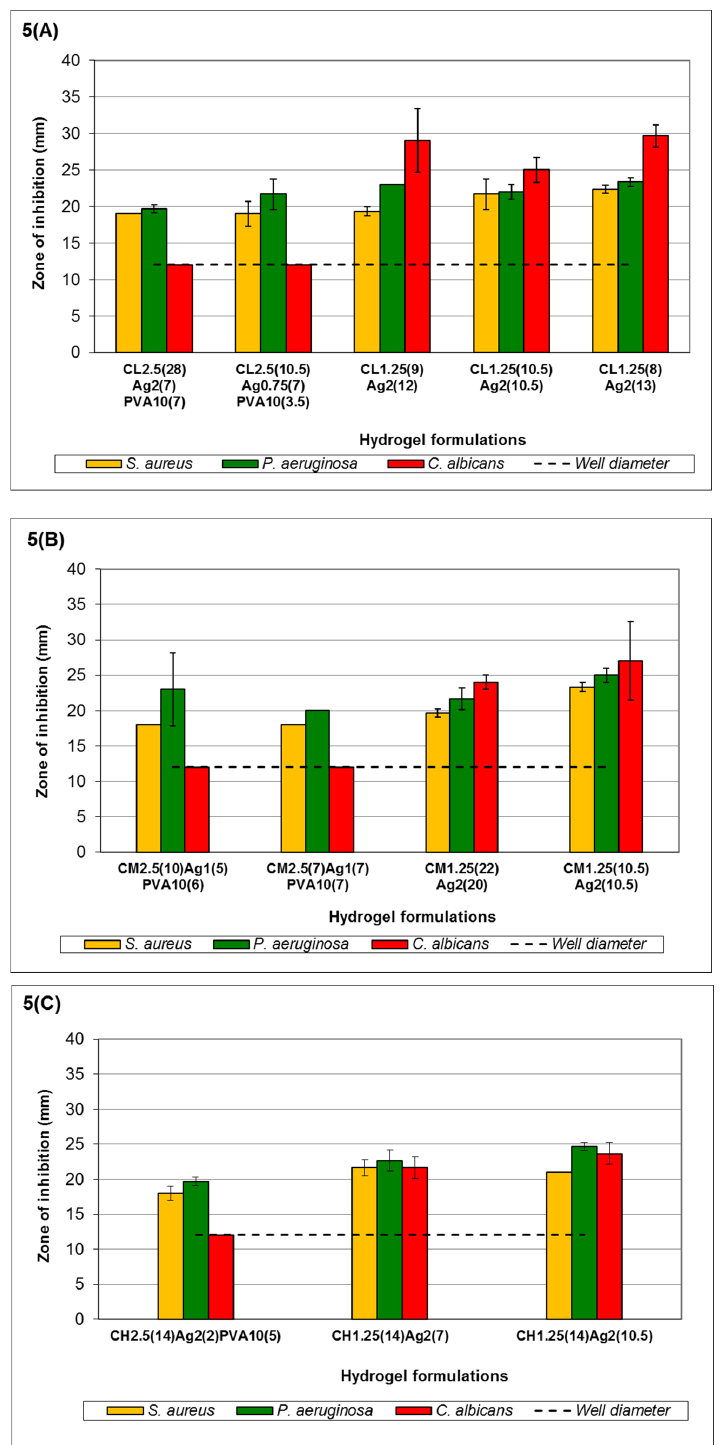
Figure 5. Antimicrobial activity of Ag + hydrogels formulated with ( A ) low ‐ viscosity chitosan; ( B ) medium ‐ viscosity chitosan; and ( C ) high ‐ viscosity chitosan. Error bars represent the standard deviation and n = 3. In all control experiments (using hydrogels without Ag + ), there was no observed ZOI (data not shown). Statistical analysis using ANOVA indicated no significant difference in the antimicrobial activity of the formulations against the selected microorganisms ( p > 0.05). The codes shown in the figure key describe the following: C L1.25 = 1.25% w / v low ‐ viscosity chitosan, C L2.5 = 2.5% w / v low viscosity chitosan, C M1.25 = 1.25% w / v medium viscosity chitosan, C M2.5 = 2.5% w / v medium ‐ viscosity chitosan, C H1.25 = 1.25% w / v high ‐ viscosity chitosan, C H2.5 = 2.5% w / v high ‐ viscosity chitosan, Ag 0.75 = 0.75% w / v AgNO 3 solution, Ag 1 = 1.0% w / v AgNO 3 solution, Ag 2 = 2.0% w / v AgNO 3 solution, PVA = PVA 30–70 kDa and the volume of the components used in each formulation are shown in the brackets. In Figure 5A, formulations with >0.2117% w / v Ag + (C L1.25(9) Ag 2(12) ‐ C L1.25(8) Ag 2(13) ) all showed a ZOI against C. albicans , unlike formulations C L2.5(28) Ag 2(7) PVA 10(7) and C L2.5(10.5) Ag 0.75(7) PVA 10(3.5) . The observed ZOI was not influenced by the small increase in Ag + concentration from 0.635% to 0.786% w / v . All formulations showed a ZOI against P. aeruginosa and S. aureus . The increase in Ag + from C L1.25(9) Ag 2(12) to C L1.25(8) Ag 2(13) showed a gradual increase in ZOI, although this increase was not significant ( p > 0.05). This may be due to the higher free Ag + MLC of P. aeruginosa (1.59 × 10 − 3 % w / v ) and S. aureus (5.08 × 10 − 3 % w / v ) compared to C. albicans (6.35 × 10 − 4 % w / v ) [43]. Medium ‐ viscosity chitosan hydrogels (Figure 5B) showed relatively similar ZOI when compared to those in Figure 5A with